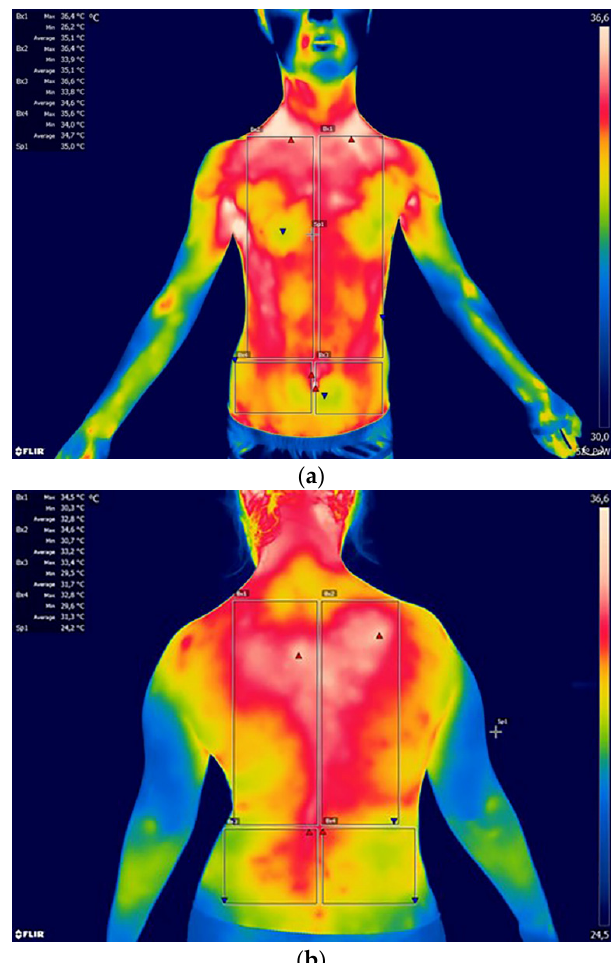
Figure 1. ( a ) Example of a thermogram with marked areas of the chest and abdomen: Bx1—chest left side; Bx2—chest right side; Bx3—abdomen left side; Bx4—abdomen right side. ( b ) Example of a thermogram with marked areas of the back: BX1—upper back left; Bx2—upper back right; BX3—lower back left; BX4—lower back right.